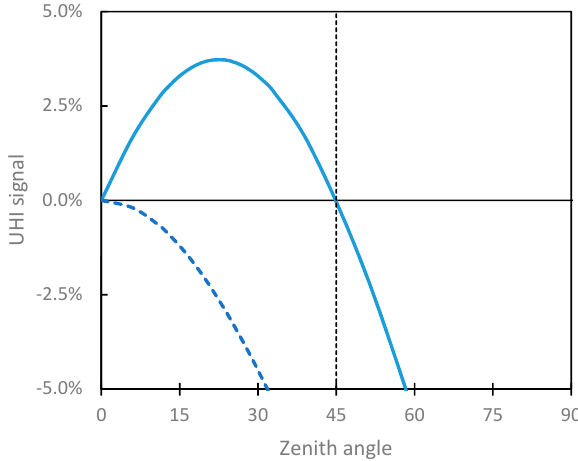
Figure 3. Irradiance balance or UHI signal for PV facades for the scenarios with a bright road (solid line) and a dark road (dashed line) as a function of zenith nce angle for (cid:2009) (cid:3045) = 30%; (cid:2009) (cid:3017)(cid:3023) = 10%; (cid:2009) (cid:3050) = 70%; (cid:2009) (cid:3034) = 30% (bright road) or (cid:2009) (cid:3034) = 0% (dark road). The dotted vertical line indicates (cid:2016) = 45° . PV efficiency assumed: 20%.